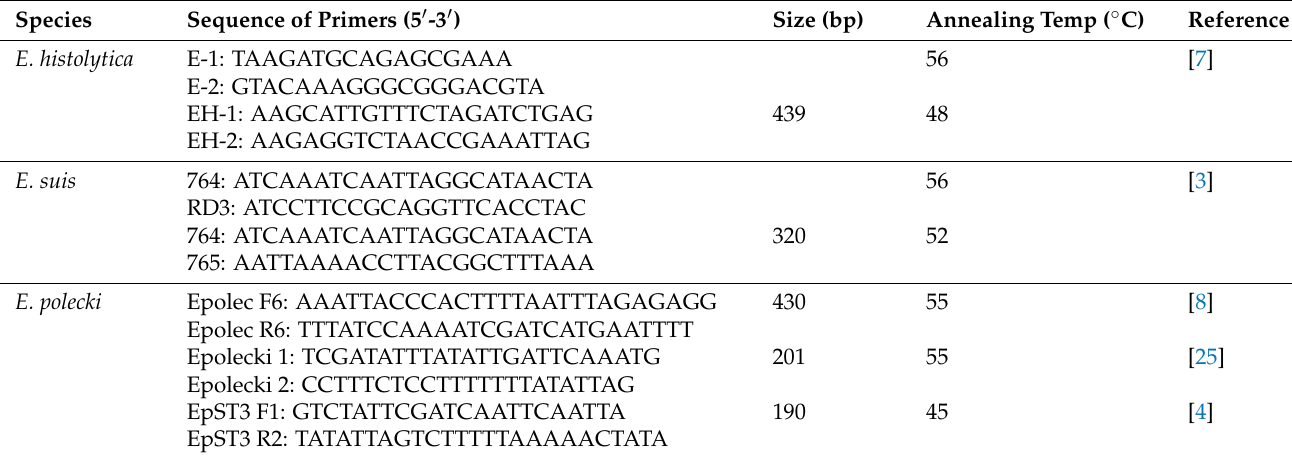
Table 2. Details of all primers in this